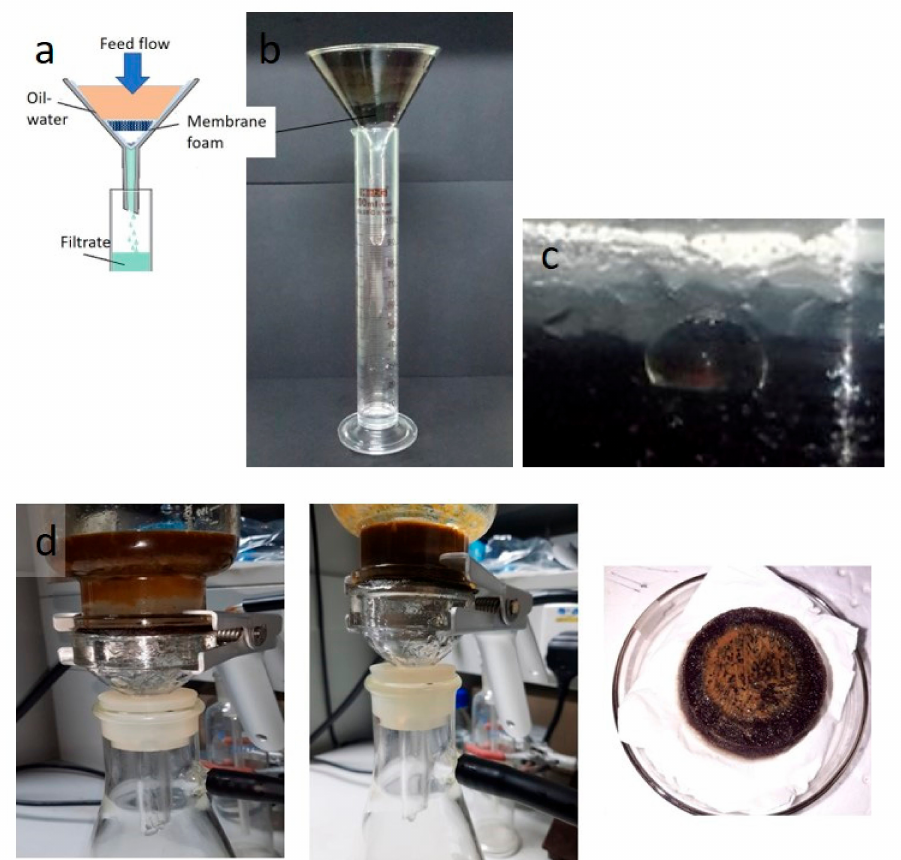
Figure 10. ( a ) Oil–water separation process using a funnel. ( b ) Membrane used to filter light crude oil–water. ( c ) Oil droplets in water at the membrane surface. ( d ) Used engine oil–water mixture before and after the separation; photograph of the membrane after the